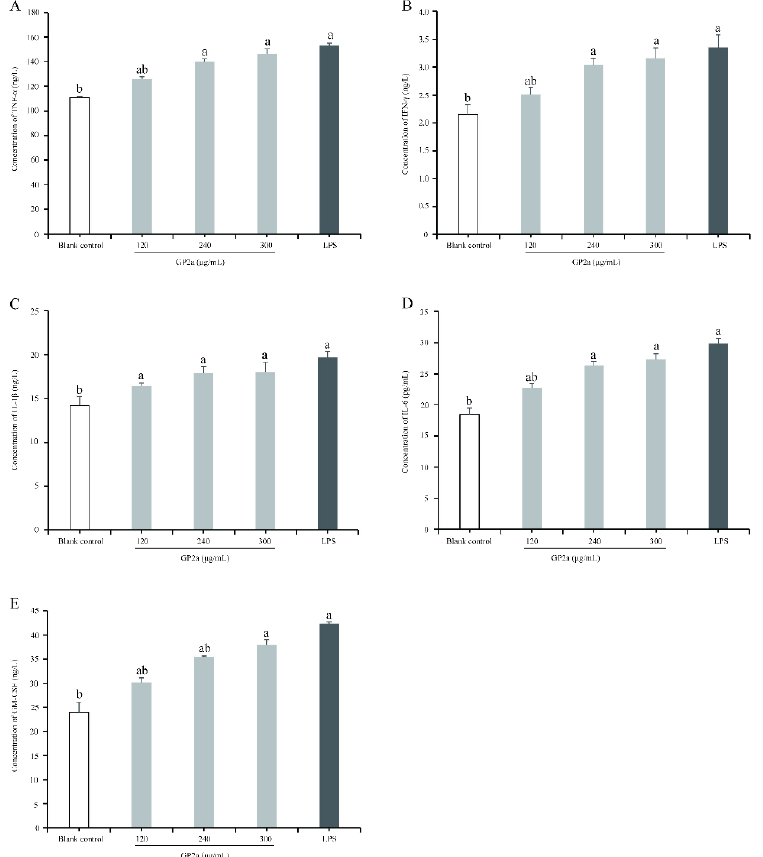
Figure 10. Effects of GP2a on cytokine production in RAW 264.7 cells. ELISA detection of tumor necrosis factor- α (TNF- α ) ( A ), interferon (IFN)- γ ( B ), interleukin (IL)-1 β ( C ), IL-6 ( D ), and granulocyte macrophage colony stimulating factor (GM-CSF) ( E ). Untreated cells were used as blank control; cells treated with different GP2a concentrations (120, 240, and 300 µ g/mL) were used as sample; cells treated with lipopolysaccharide (LPS) (2 µ g/mL) were used as positive control. Letter a represents significant difference compared with the blank control ( p < 0.05, p < 0.01); letter b represents significant difference compared with the positive control ( p < 0.05, p <